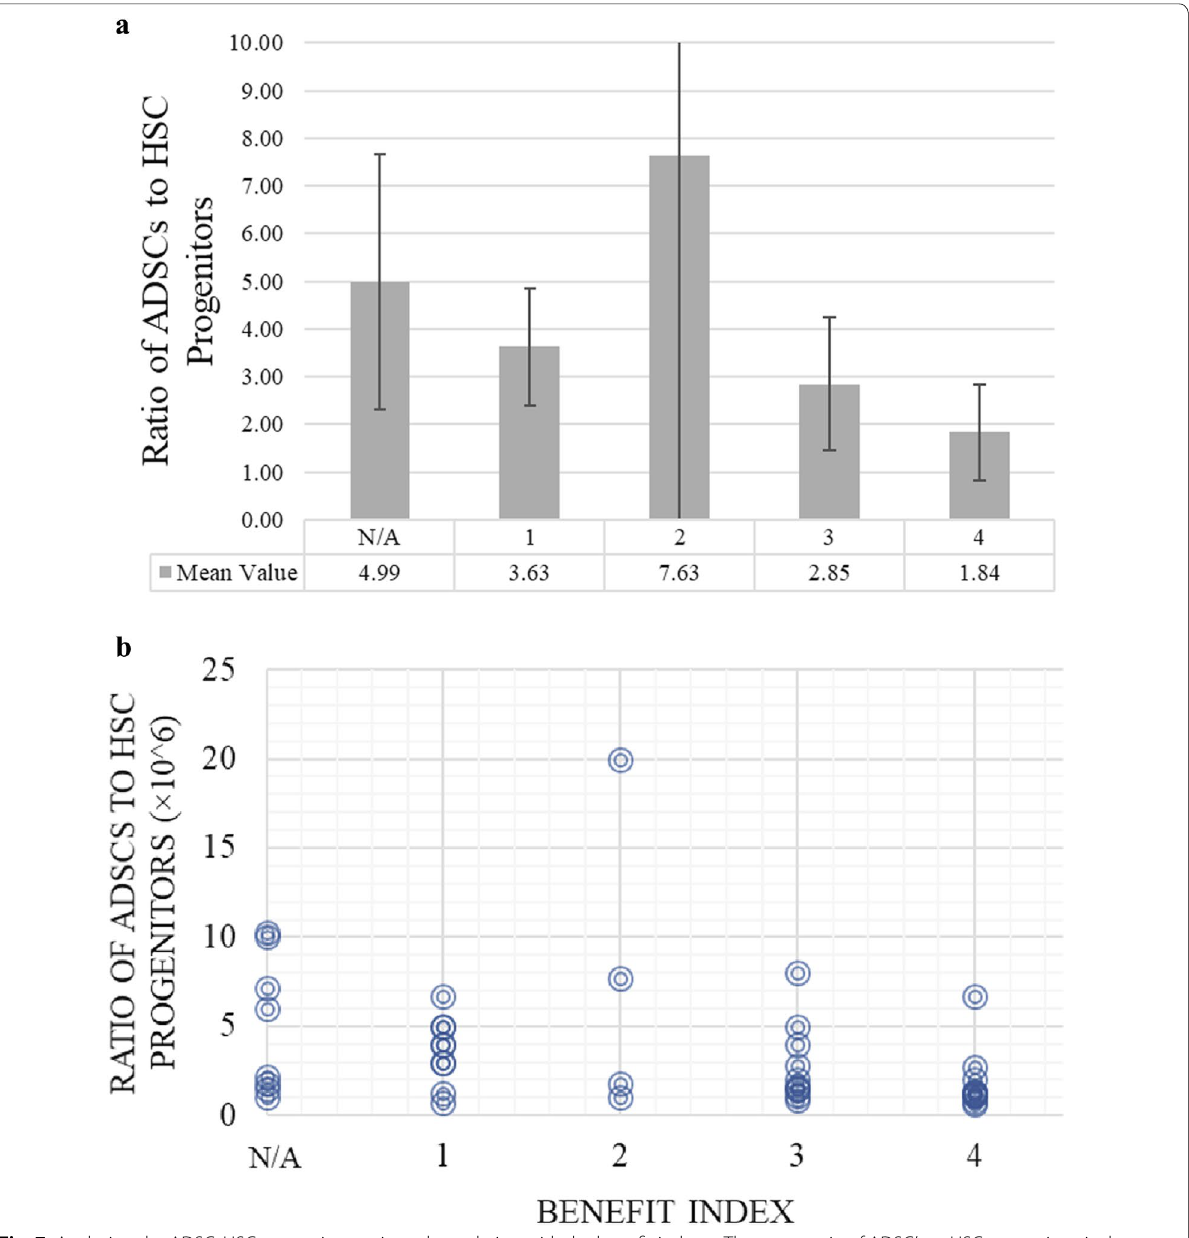
Fig. 7 Analyzing the ADSC: HSC-progenitors ratio and correlating with the benefit index. a The mean ratio of ADSC’s to HSC progenitors is shown as the height of the bars, and the benefit index is shown as the X-axis. The error bars represent the 95% confidence interval. b The raw data from which a was derived is shown as a scatter-plot, with the ratio as the Y-axis and the reported benefit index as the X-axis. The Y-values are shown as 10 6 , and a downward trend is clearly visible in a , suggesting a correlation between the ratio and the benefit of the ×